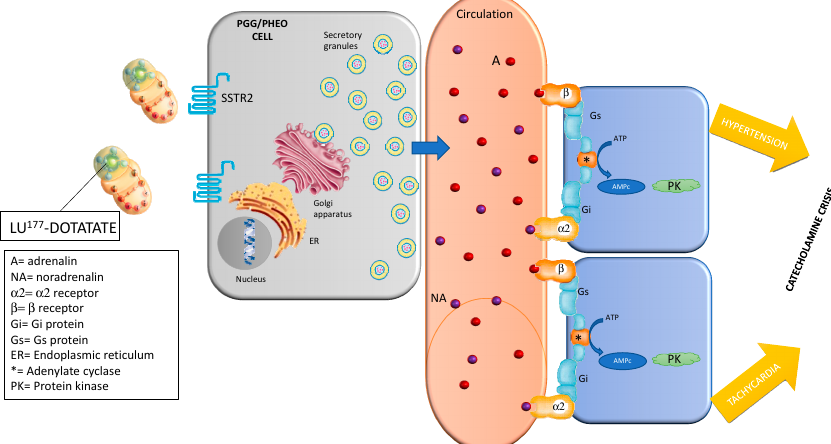
Figure 1. Physiopathology of hormonal crisis during Lu-DOTATATE treatment (catecholamine crisis). Somatostatin receptor 2 (SSTR2); adenosine triphosphate (ATP); cyclic adenosine monophosphate (AMPc); Paraganglioma (PGG); Pheochromocytoma (PHEO).